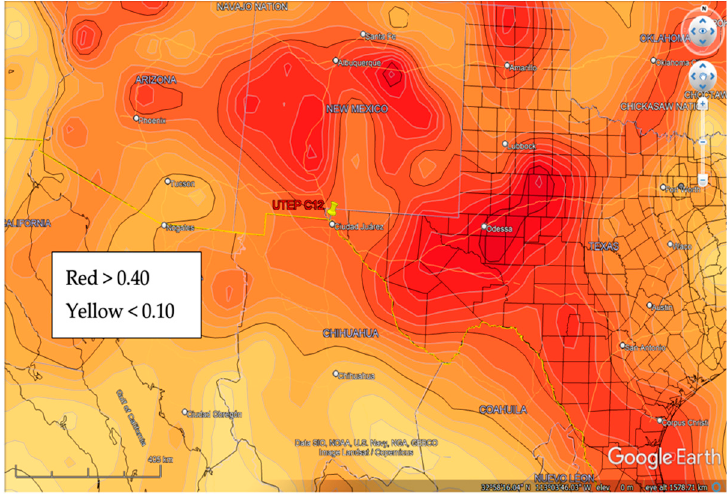
Figure 11. Potential source contribution function for ozone in El Paso, May–September 2013–2019, trajectories run from noon MST (19 UTC) 100 m, 500 m, 1000 m AGL, 1 deg. Long. x 1 deg. Lat., 80 miles to 800 miles from El Paso.